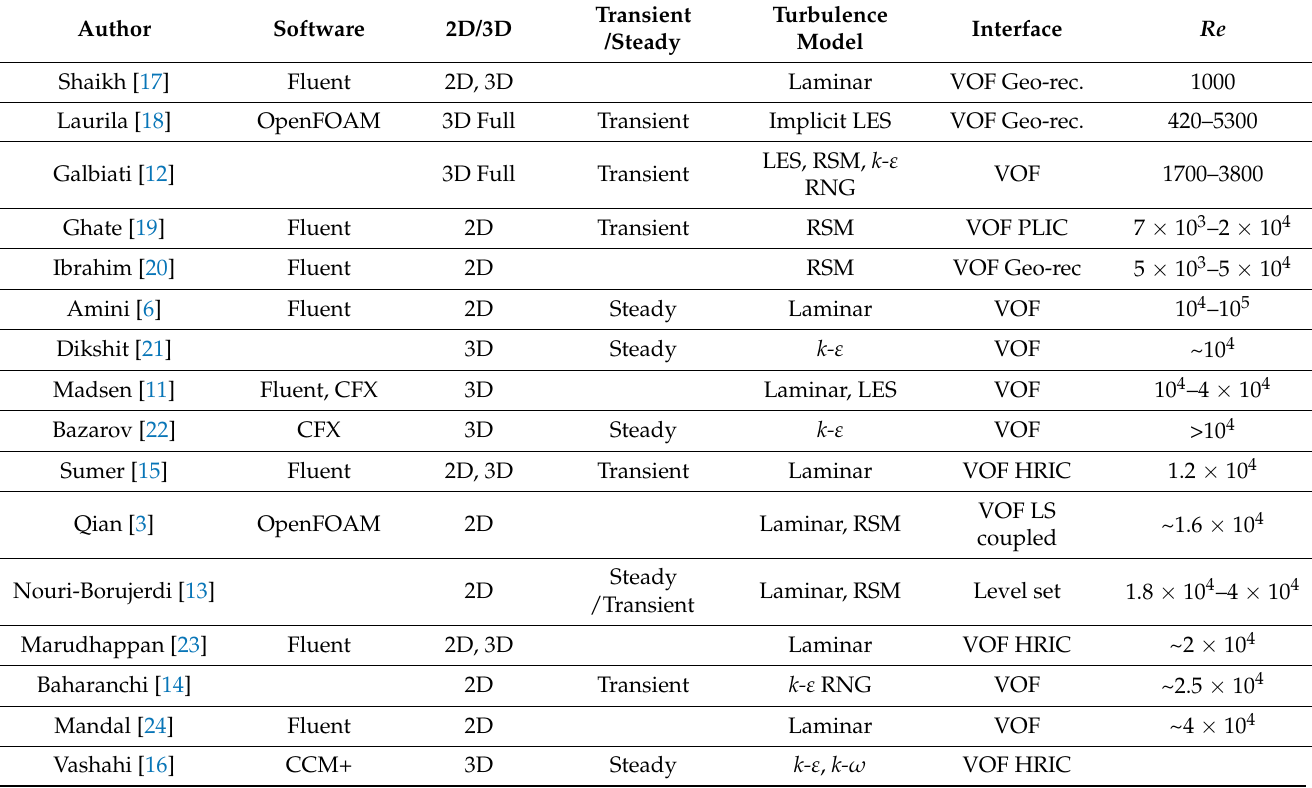
Table 1. Review of published numerical